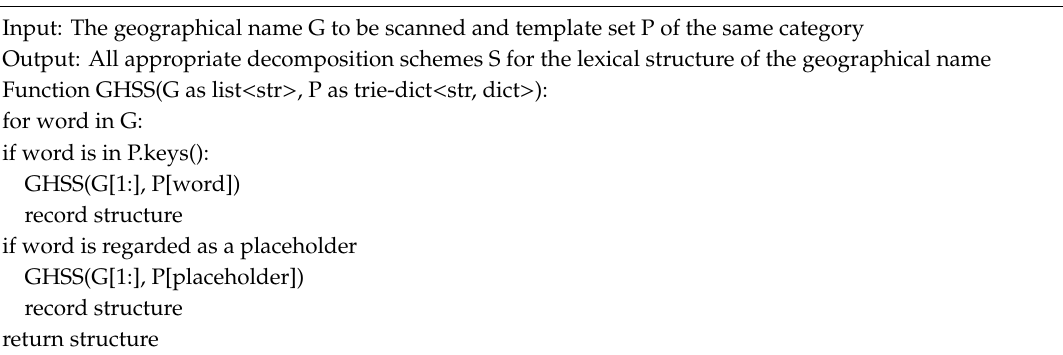
Algorithm 1 : Lexical structure analysis algorithm for geographical Table 2. Lexical structure analysis algorithm for geographical names. Algorithm1: Lexical structure analysis algorithm for geographical names